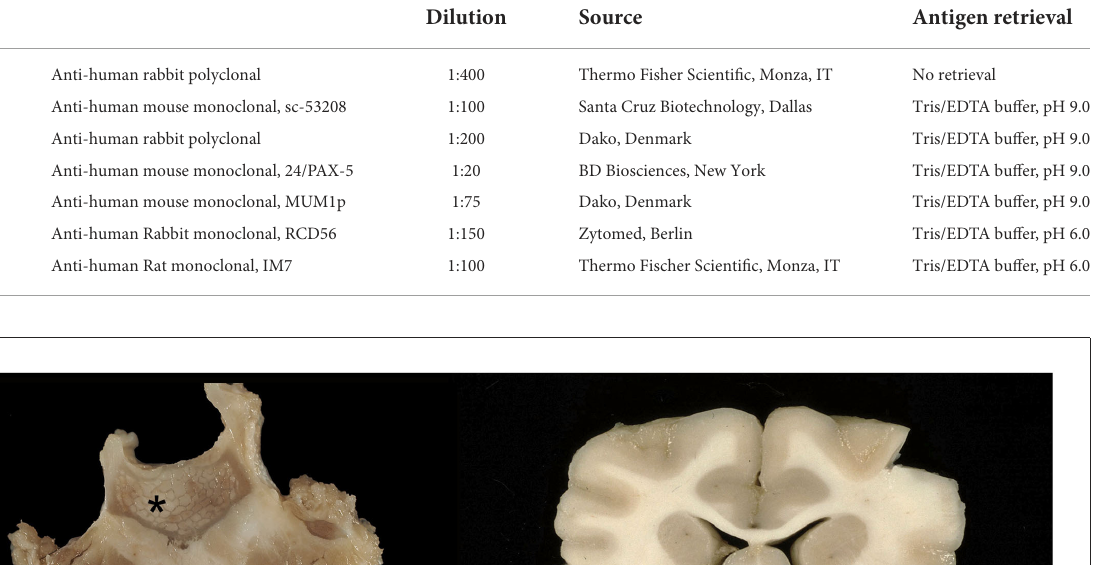
TABLE 2 Primary antibodies and antigen retrieval methods used in immunohistochemical investigations.